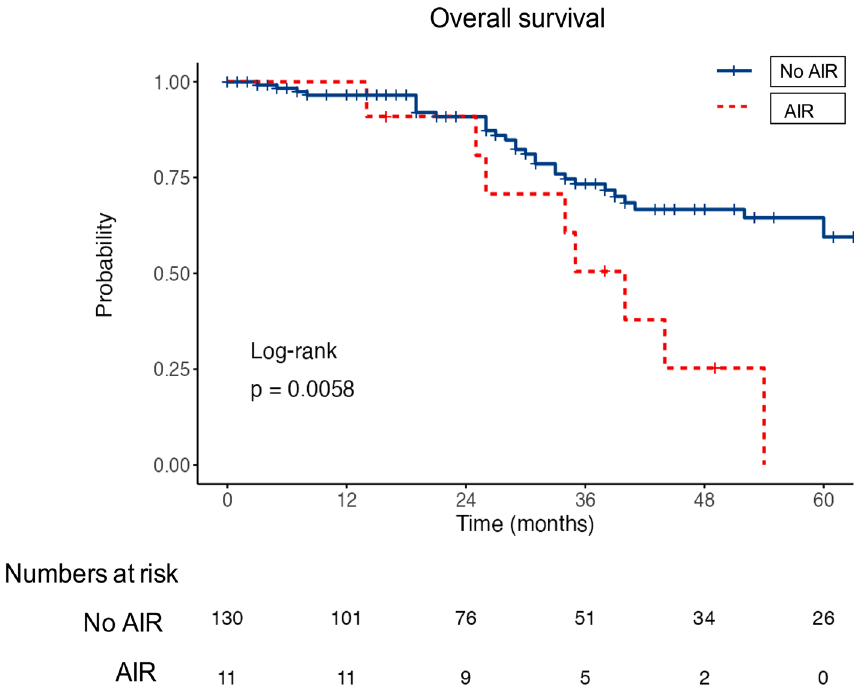
Figure 5. Overall survival according to the presence of aggressive intrasegmental recurrence in the subgroup of patients with nodules smaller than 3 cm and without infiltrative tumors. The cox-proportional hazard assumption is fulfilled in the analyses.